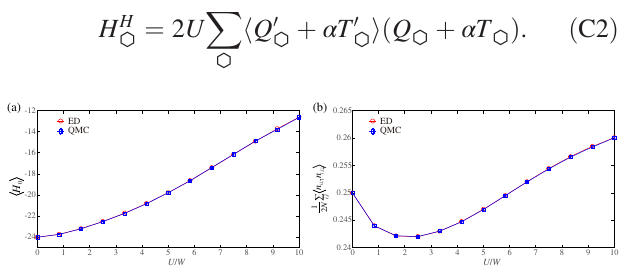
FIG. 6. (a) Kinetic energy and (b) double occupancy as a function of U=W for α ¼ 0 . 3 . Red circles and blue squares with error bars are obtained from ED and QMC,